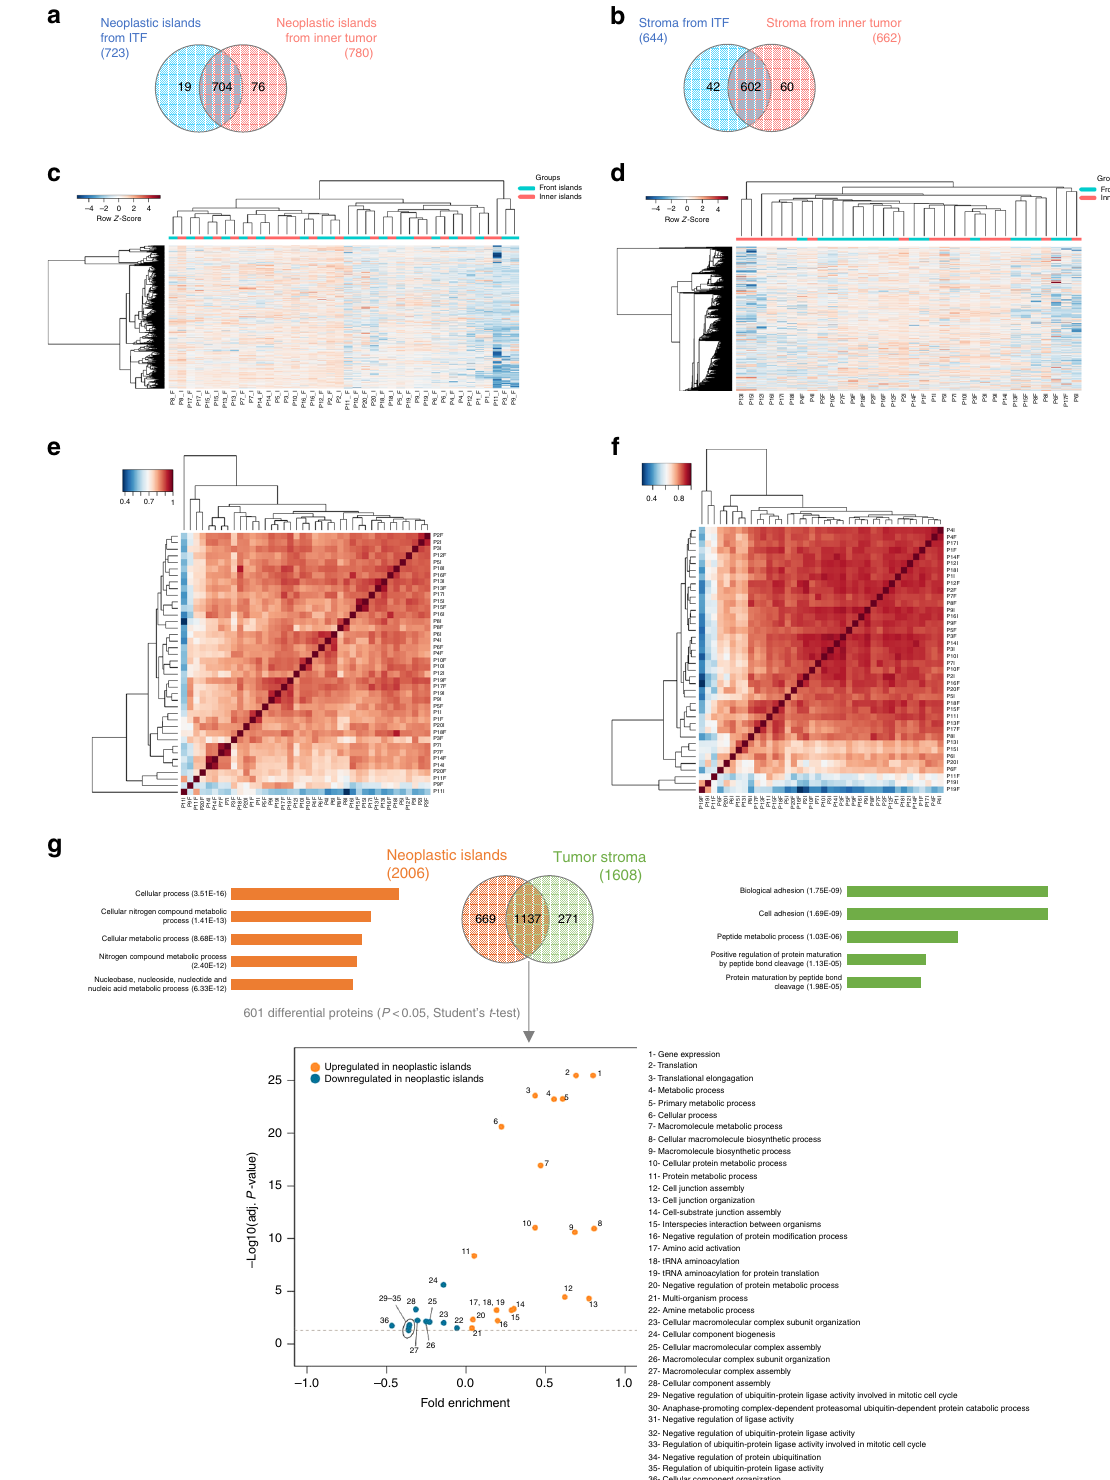
Cystatin-B (CSTB), leukotriene A-4 hydrolase (LTA4H), protein NDRG1 (NDRG1), and phosphoglycerate kinase 1 (PGK1) from the neoplastic island dataset and collagen alpha-1 (VI) chain (COL6A1), integrin alpha-V (ITGAV) and myoglobin (MB) from the tumor stromal dataset were prioritized (Fig. 3; Supplementary Fig. 5). All these proteins, according to the literature and to the domain predictions performed here, are nonclassically secreted (Supplementary Data 18).